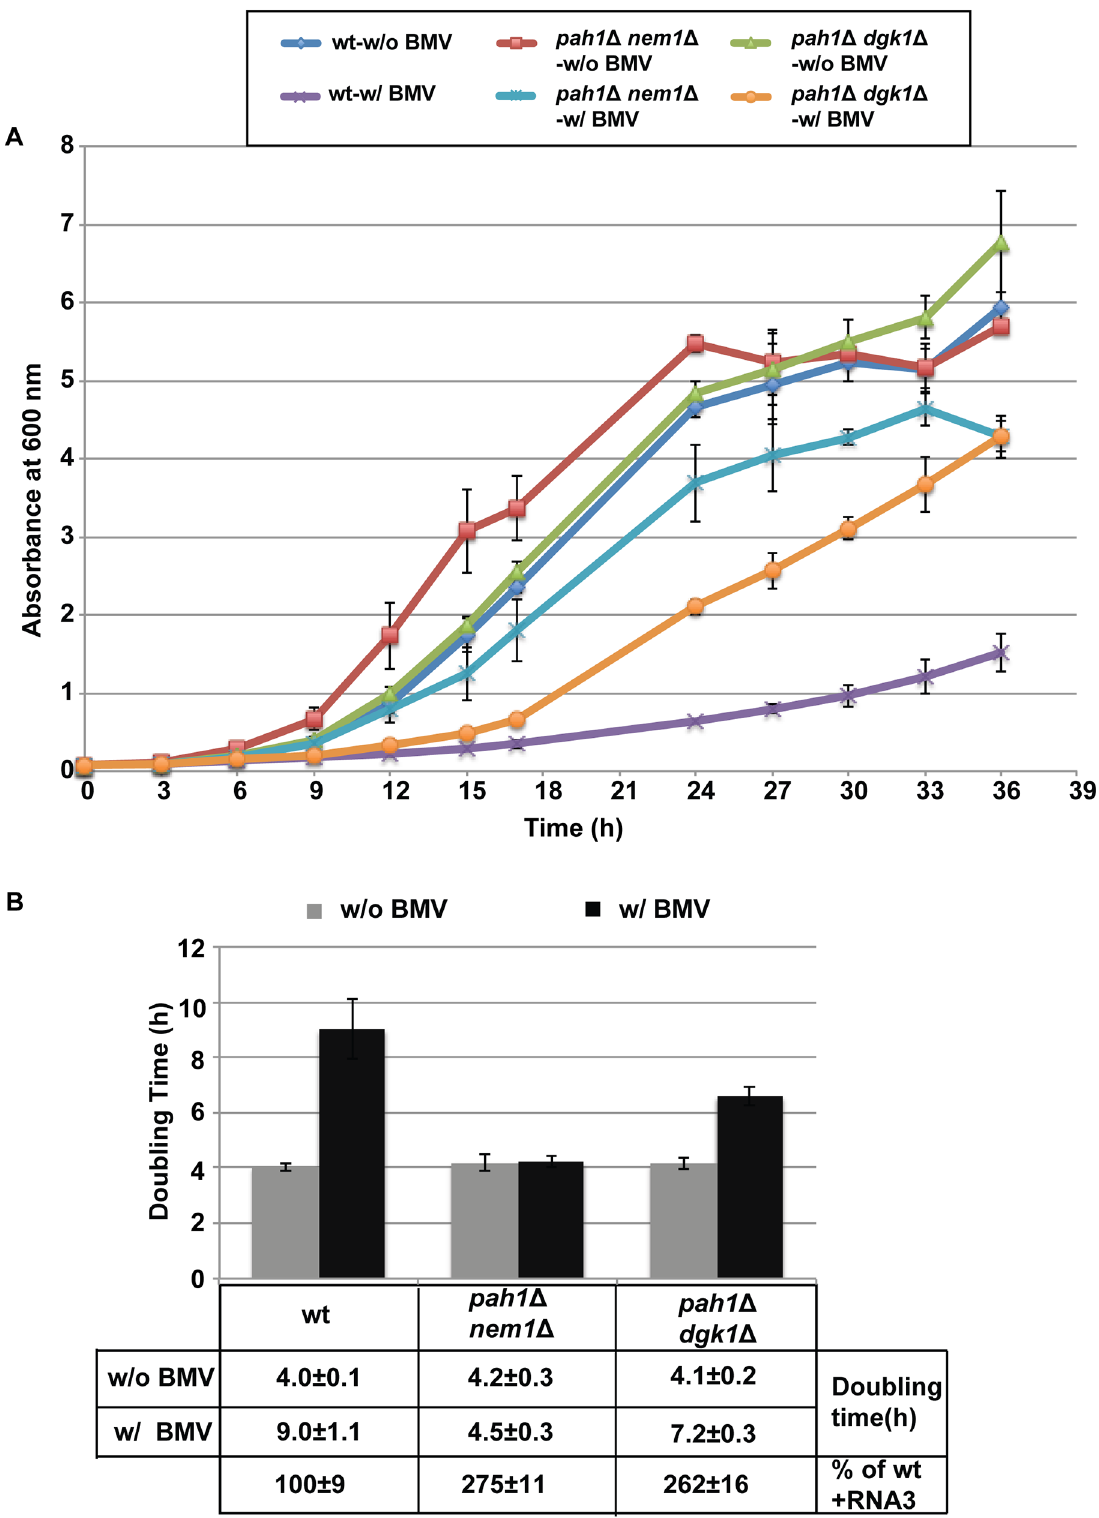
Fig 9. Deleting PAH1 alleviates BMV-repressed host cell growth. Cells of wt or mutants were grown in media using galactose as the carbon source in the absence or presence of BMV replication. (A) Growth curves of wt, pah1 Δ nem1 Δ ,and pah1 Δ dgk1 Δ cells in